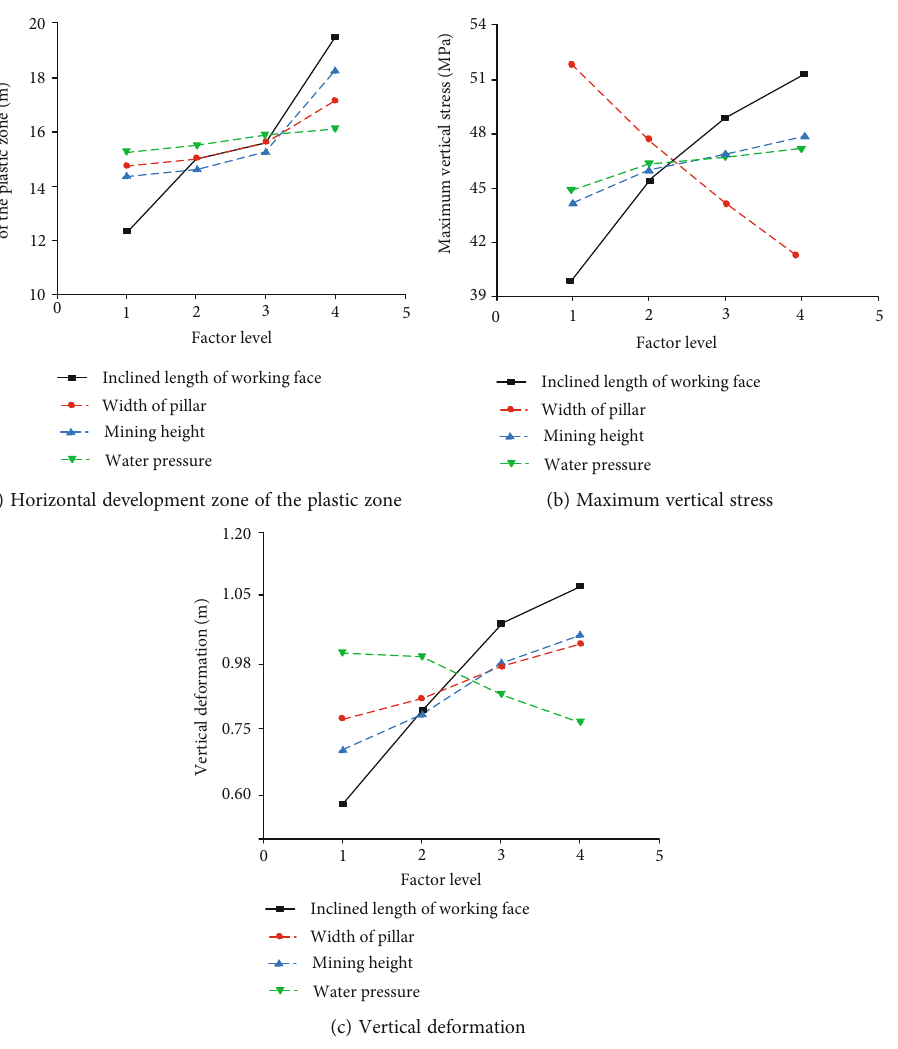
Figure 9: Trend chart of average results under di ff erent levels of